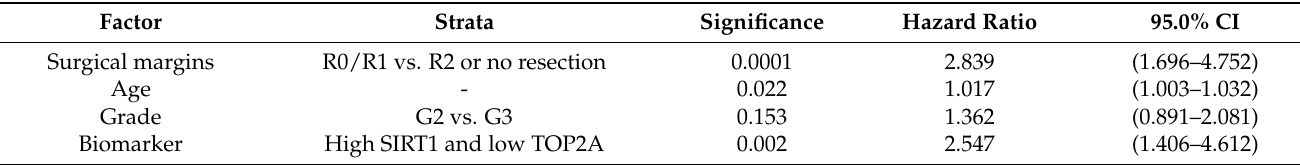
Table 4. Multivariate analysis of overall survival 2. A Cox proportional hazards model for overall survival was calculated, including the favorable “Top Survivor” biomarker combination (low TOP2A and high SIRT1) and statistically significant clinical